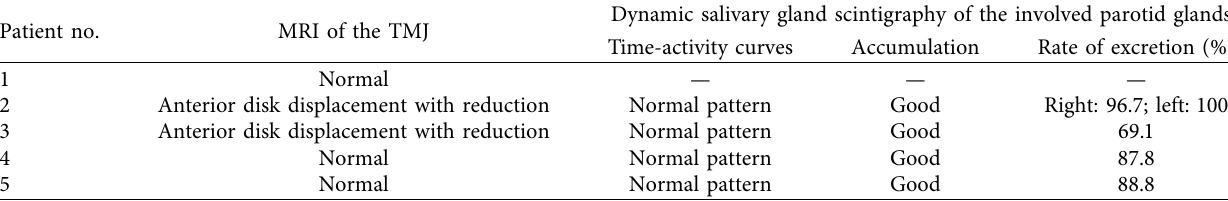
Table 3: Imaging findings in patients with idiopathic first bite syndrome. Patient no.